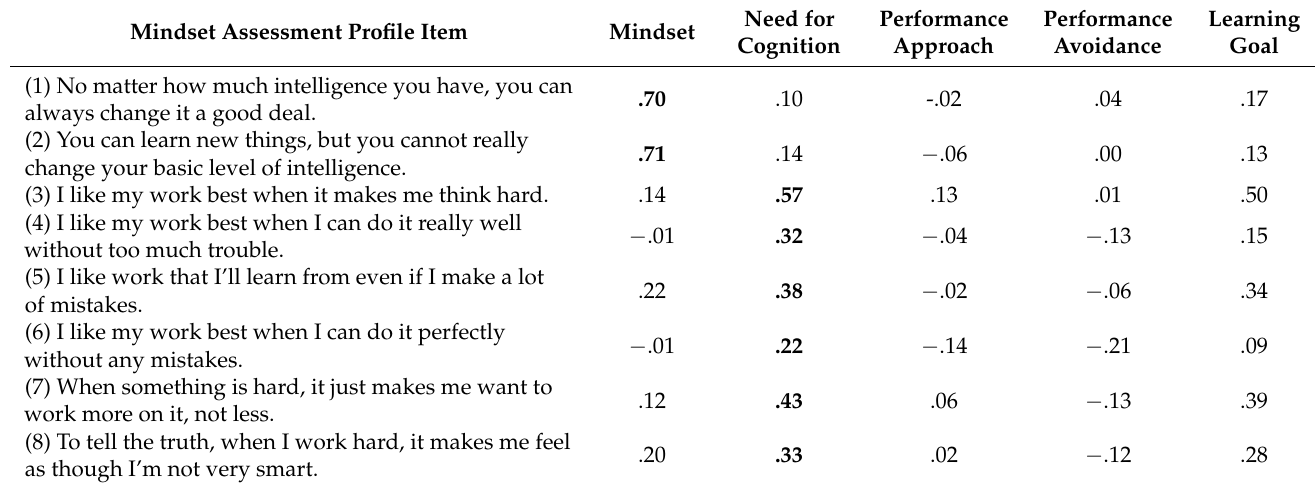
Table 3. Correlations between items in the Mindset Assessment Profile and personality measures. Mindset Assessment Profile Item